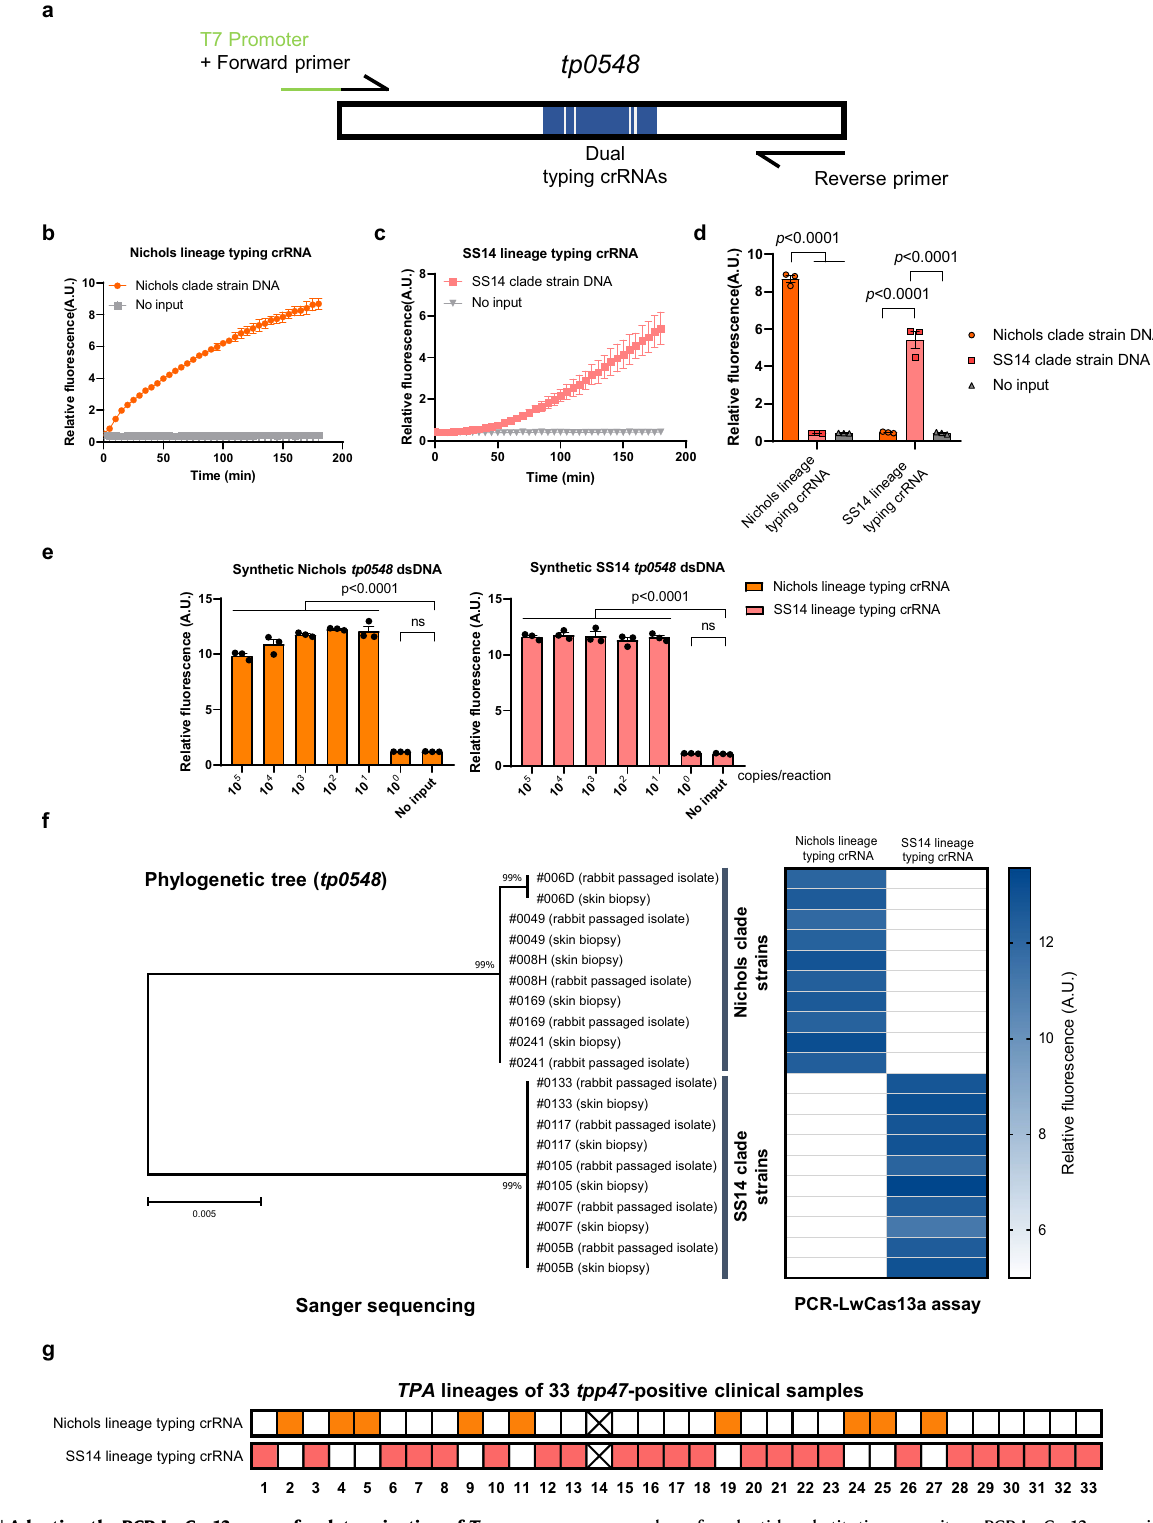
number of nucleotide substitutions per site. g PCR-LwCas13a assay identi fi ed the TPA lineages for 32 of 33 tpp47 -positive clinical samples. Squares with color represent positive signals, whilewhite squares represent negative results. Squares withcrossrepresentsnopositivesignalsdetectedbyeitherNicholsorSS14lineage crRNAs. Abbreviations: A.U. Arbitrary units. n =3 technical replicates; two-tailed Student t -testwasusedtoanalyzethestatisticalsigni fi cance; p -valuewaslabeledin the fi gure, ns=not signi fi cant; error bars represent mean±SEM. Source data are provided as a Source Data fi